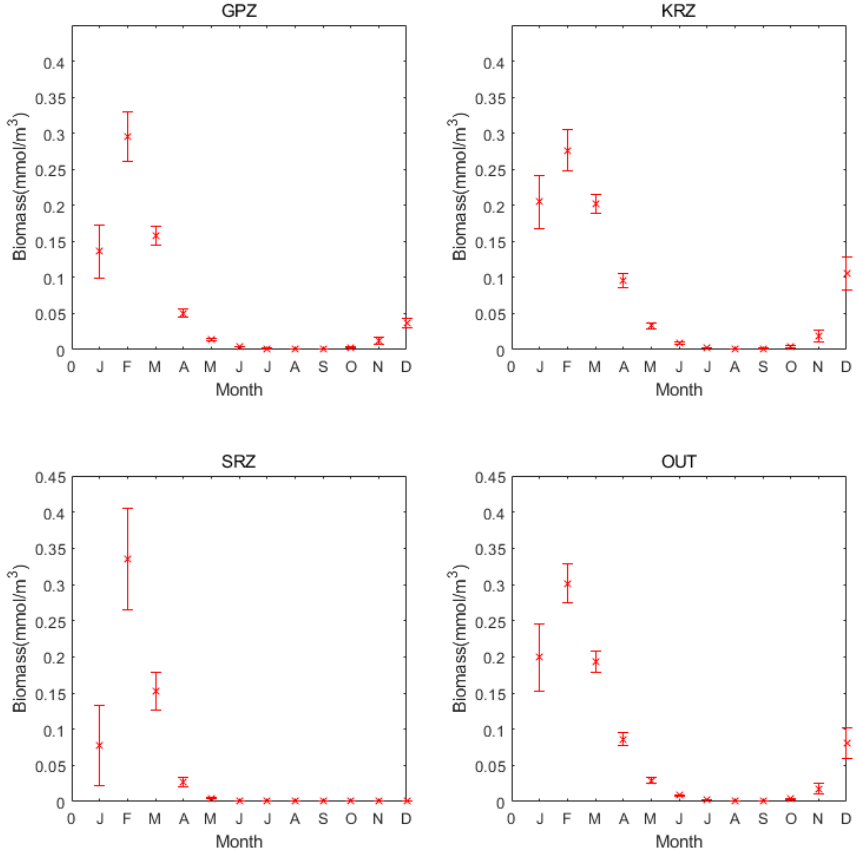
Figure 7. Monthly average biomass and variance of the different regions from 1958 to 2018.